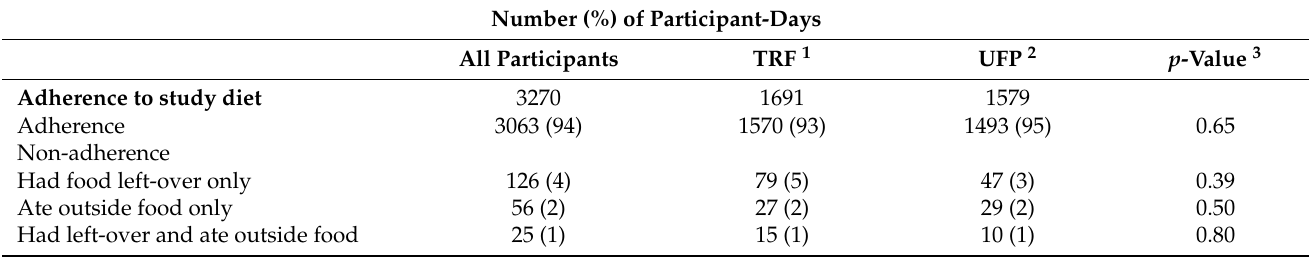
Table 3. Adherence to food consumption overall and by study arm.